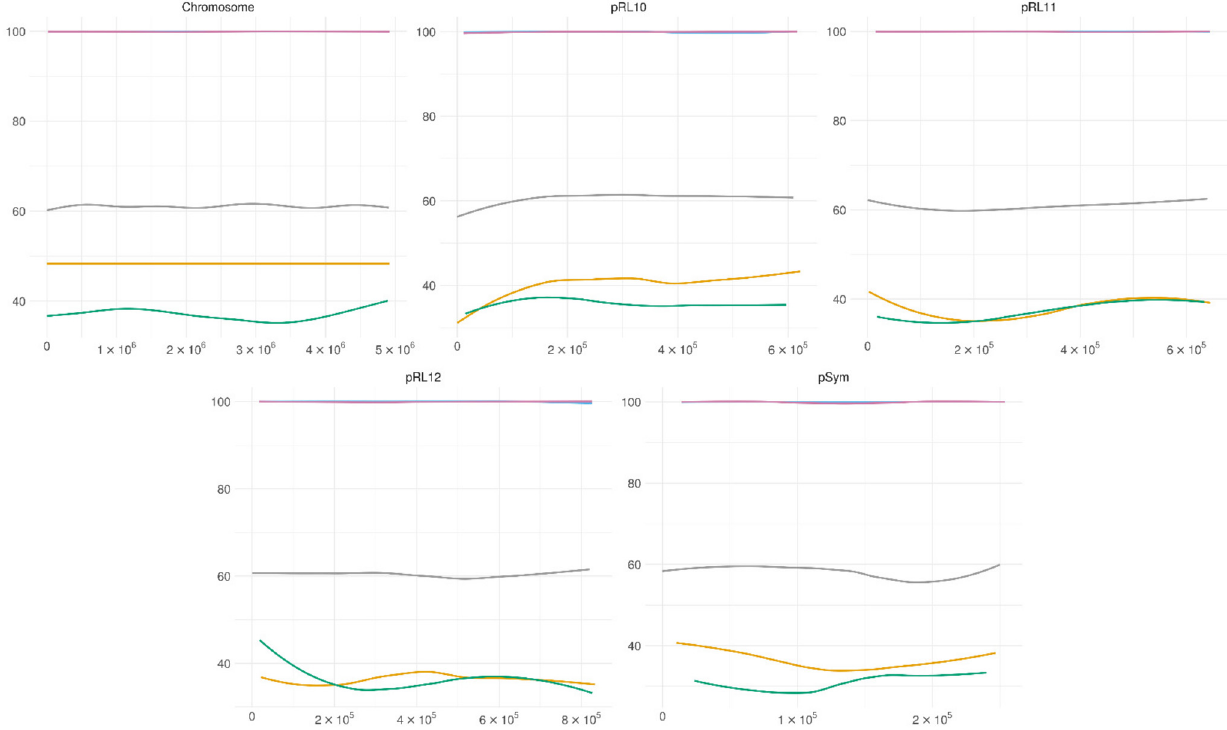
Figure 3. GGCGCC methylation across the replicons. Blue—GGCGCC motif methylation in bacteroids, purple—GGCGCC motif methylation in cell culture, yellow—methylation of cytosine in bacteroids, green—methylation of cytosine in bacteroids, grey—GC content. Solid lines—polynomial regression lines calculated using ggplot_smooth “loess” method, formula “y~x”.